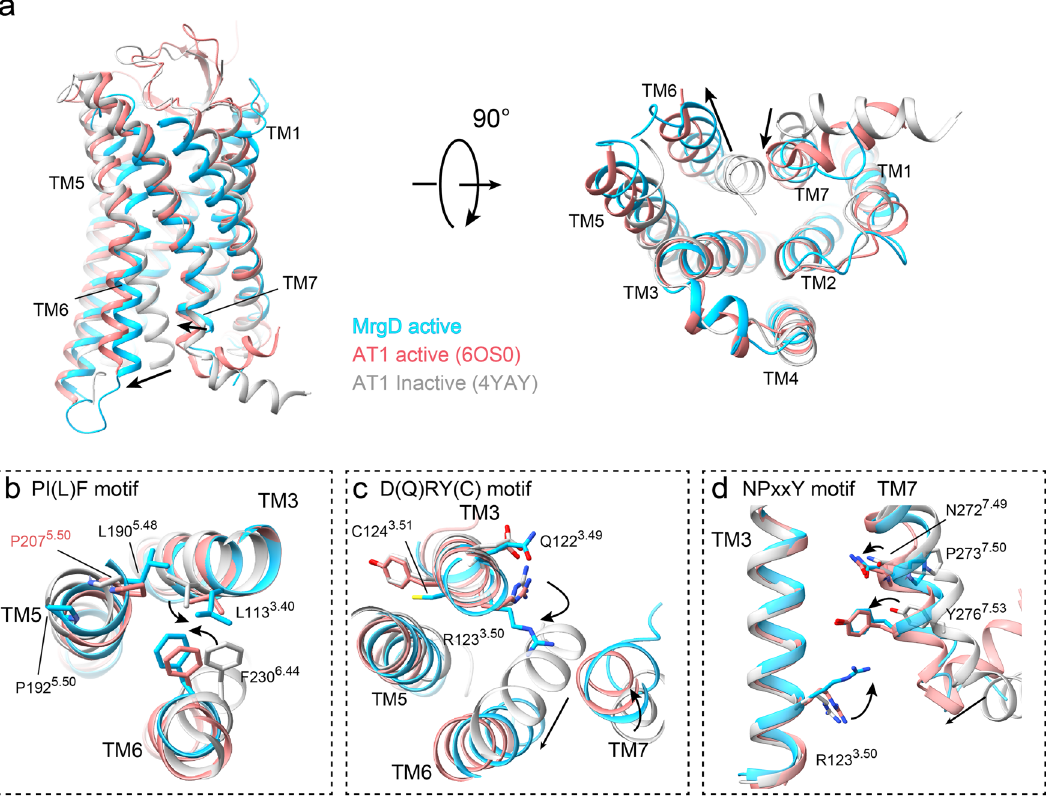
Fig. 3 Active conformation of the MrgD receptor. a Superposition of the β -alanine-bound active MrgD receptor (cyan), active Angiotensin II type1 (AT1) receptor (salmon, PDB code: 6OS0), and antagonist-bound AT1 receptor (gray, PDB code: 4YAY) models at two different angles. The movement of TM6 and TM7 in the MrgD receptor relative to inactive AT1R is indicated by black arrows. b – d Detailed views of the three motifs: PIF motif ( b ), DRY motif ( c ), and NPxxY motif ( d ). Each residue in the motifs is shown as a stick model. The difference in the orientation of the side chains from the inactive AT1R is shown in black arrows. The alignment is based on only the receptor